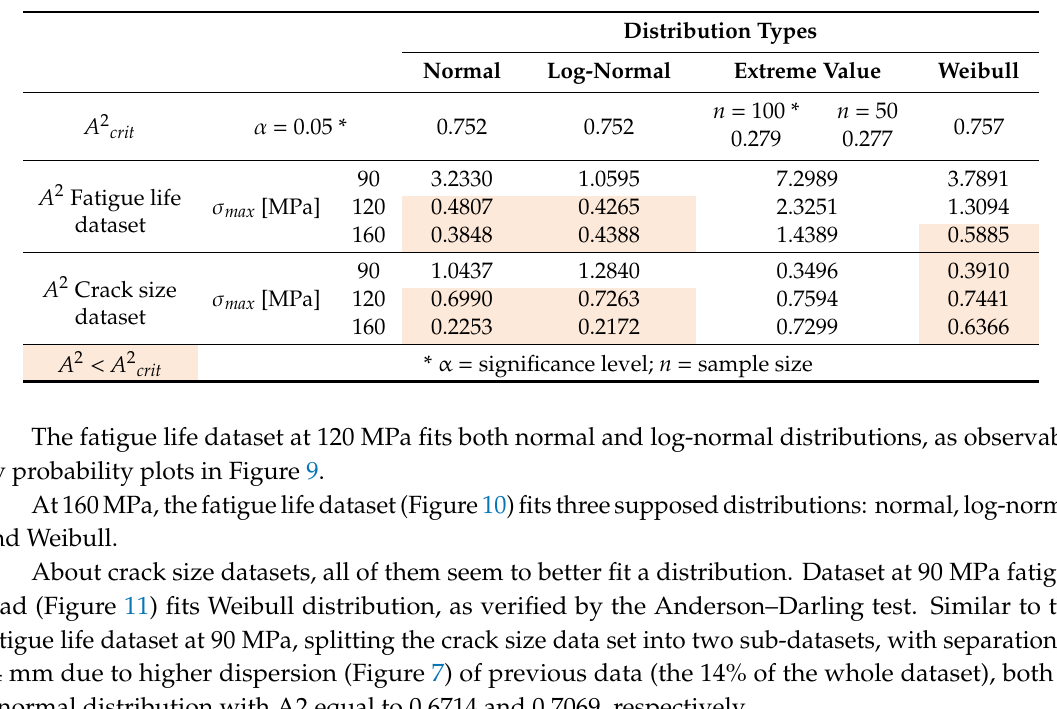
Table 5. Critical and test Anderson–Darling statistic values, A 2 crit and A 2 , for most common distribution types for fatigue life and crack size datasets.